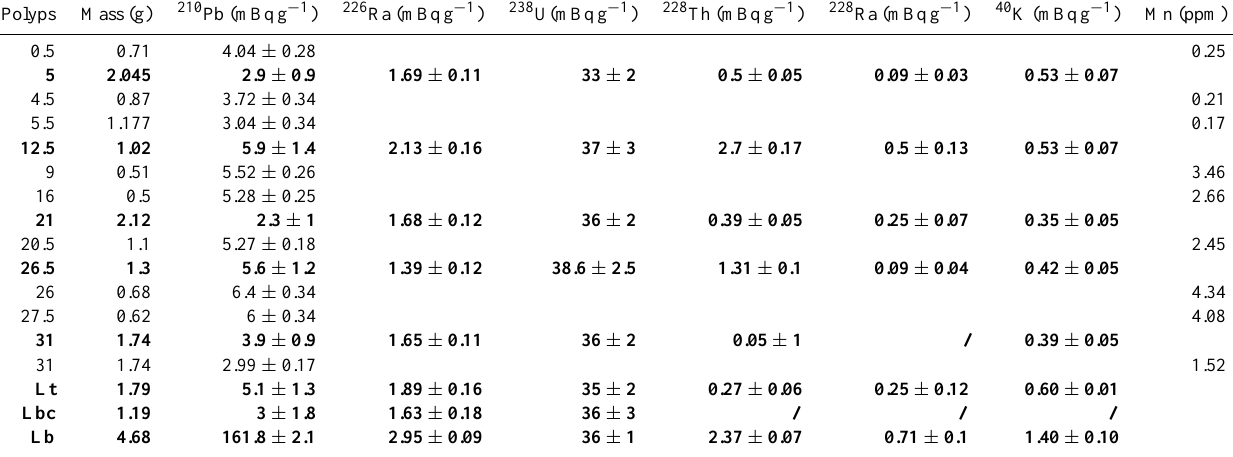
Table 2. Radiometric data from the Lophelia pertusa specimen, activity was determined as milli-Becquerel per gram (mBqg − 1 ) with standard deviation at 1 σ . In bold, data obtained by gamma spectrometry with activities of 210 Pb, 226 Ra, 238 U, 228 Th, 228 Ra and 40 K. In regular, 210 Pb activities obtained by alpha spectrometry. Some samples are below the limit of detection (/). Mn contents were expressed in